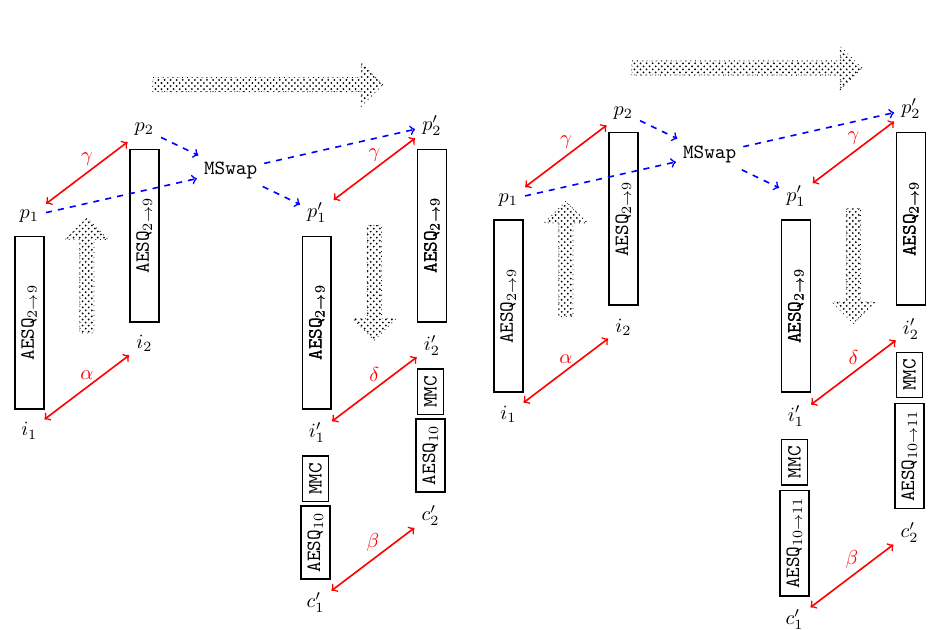
Figure 10: Improbable Differential Yoyo distinguisher for 9/10-round